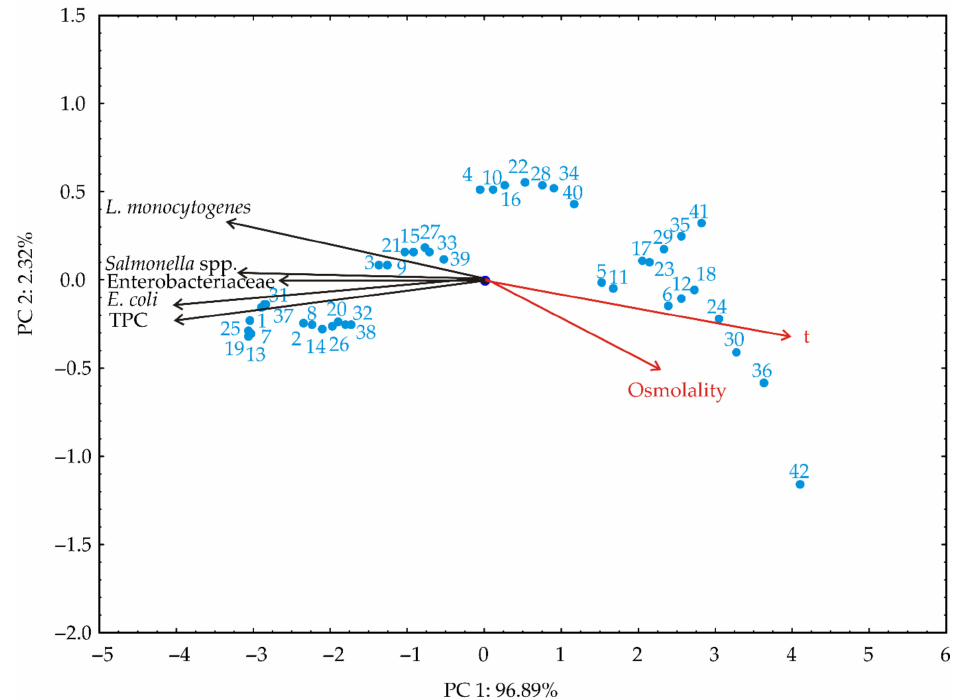
Figure 3. PCA of independent variables and the responses of the microorganisms’ viability.